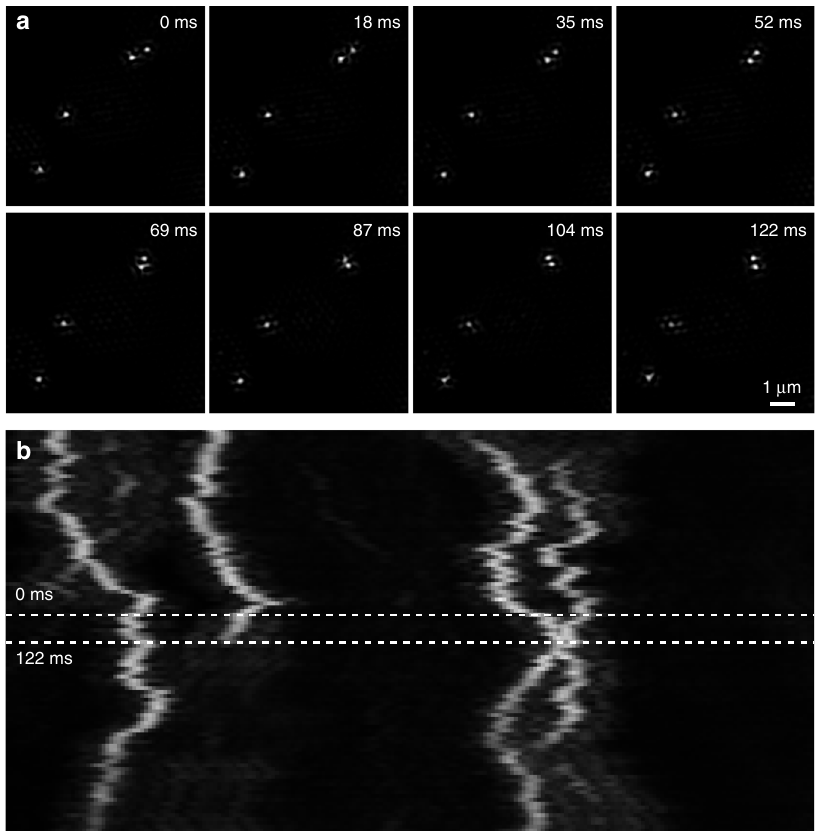
Fig. 4 Demonstration of the high image frame rates achieved by high-speed SR-SIM. a Cutouts of eight consecutive SR-SIM frames taken at 57.8 SIM frames (520 raw frames) per second, with 0.5 ms illumination time for each of the nine raw frames per SR-SIM image. The sample consists of 0.2 µ m TetraSpeck Microspheres in a 50/50 mixture of stock solution and glycerol. The excitation wavelength was 647 nm, laser power was about 3 mW before entering the objective lens. The short acquisition time allows the acquisition of images with low motion blur, even though the sample is diffusing quickly, and the high SR-SIM frame rate leads to a high temporal resolution. b Movement of the diffusing microspheres along the x -axis over time displayed as a kymograph. It spans over 107 consecutive SIM frames, or ~1.85 s, including the images shown in ( a ). Note that the diffusing microspheres could also be observed in real time and super-resolution by the system operator. Fixed microspheres were also imaged to demonstrate the general capabilities of the SIM system, see Supplementary Fig.